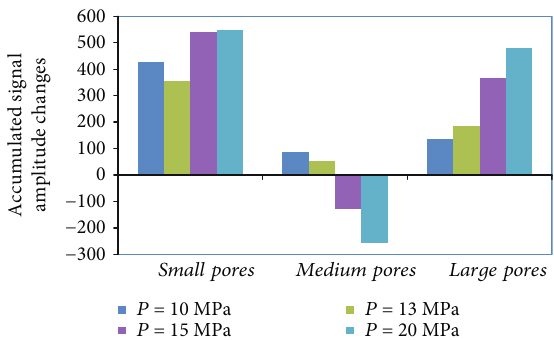
Figure 11: Probability distribution of cores saturated with no scale- forming ions water under di ff erent pressures before and after CO